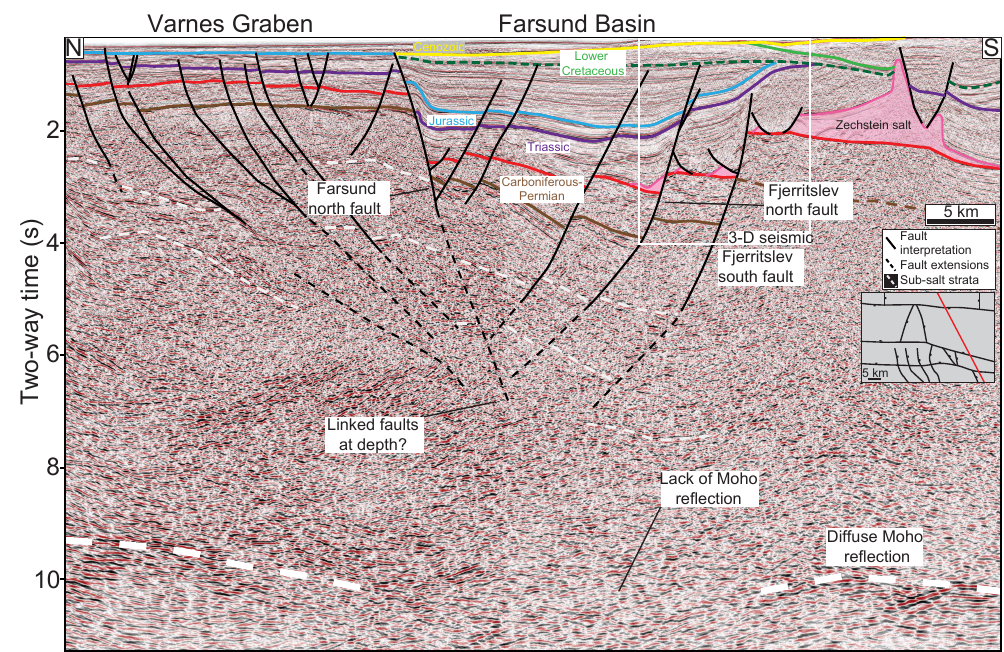
Figure 2. Interpreted N–S-oriented 2-D seismic section across the Farsund Basin showing the linked and crustal-scale nature of the E–W- oriented basin bounding faults. The lack of Moho reflection directly beneath the basin may imply that the fault cross-cut the Moho in this area and extends through the crust. See Fig. 1c for